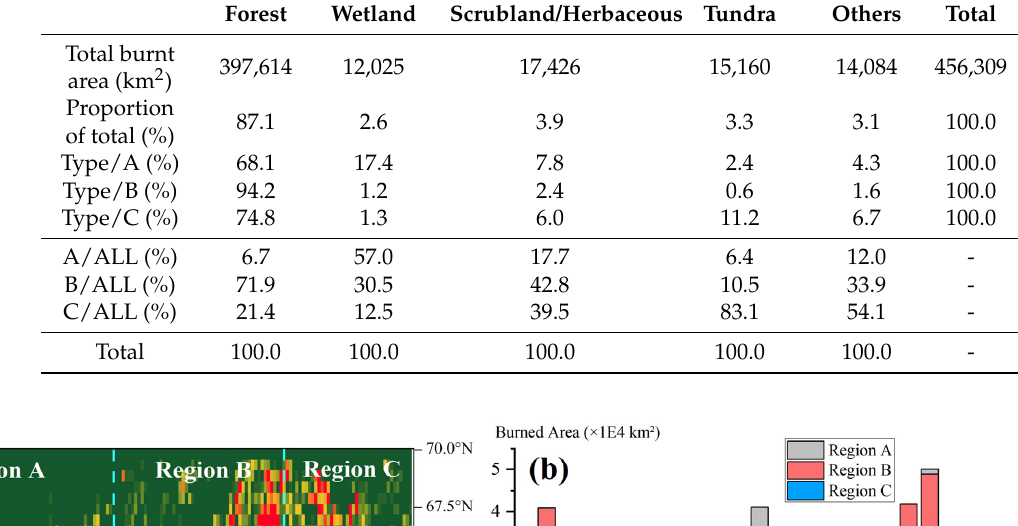
Table 2. 20-year total burnt area for each of the five main land-cover types. The other land-cover classes include non-vegetated classes of urban areas, bare areas, and areas labeled as water bodies. “Type/A (%)” represents the area burnt for each land-cover type as a proportion of the area of region A. “A/ALL (%)” represents, for the total burnt area of the specified land-cover type, the proportion contributed by region A.